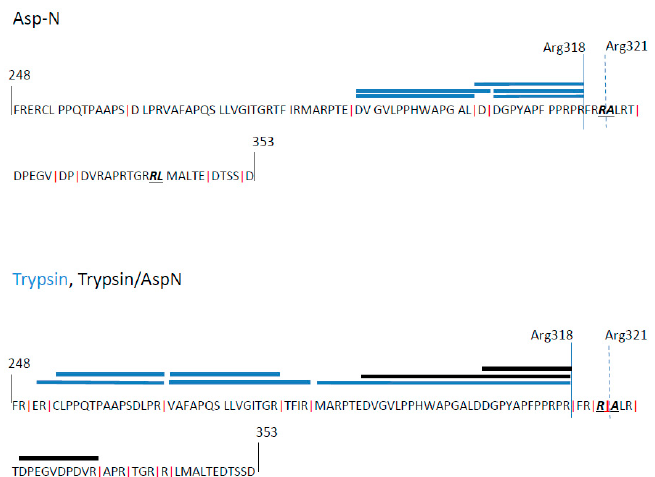
Figure 7. LC–MS analysis identifies C-terminal residue of SgG2. Protein sequence surrounding CS region with cleavage sites for Asp-N and trypsin proteases, indicated by vertical red lines (XX ↓ DXX or XR ↓ XX, respectively). Blue (Trypsin or AspN) and black (Trypsin/AspN-digest) bars overlaying sequence indicate length and position of the unique peptides identified by LC–MS of SgG2 sequence. All identified peptides covering the Arg321 (predicted cleavage indicated by discontinuous vertical line) end at Arg318 instead (solid blue vertical line).